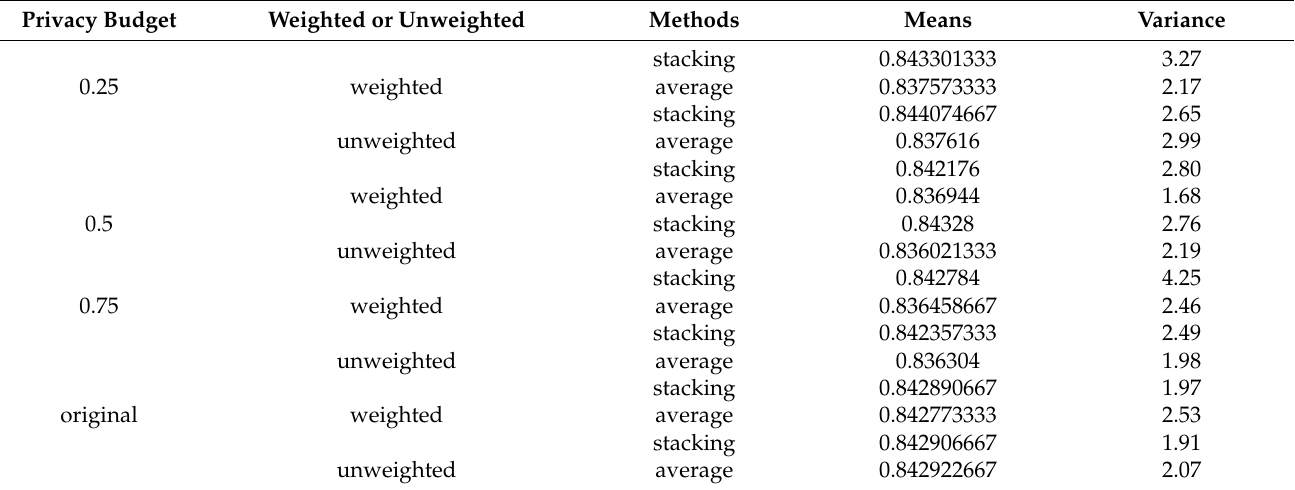
Table 5. Situation change table for updated global h 2 models calculated using different methods over t 2 time.